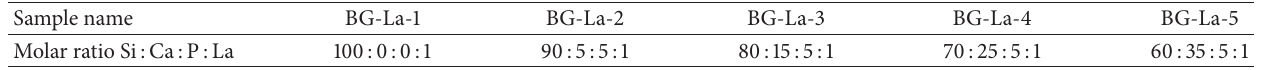
Table 1: Chemical compositions and the amounts of the reactants of different